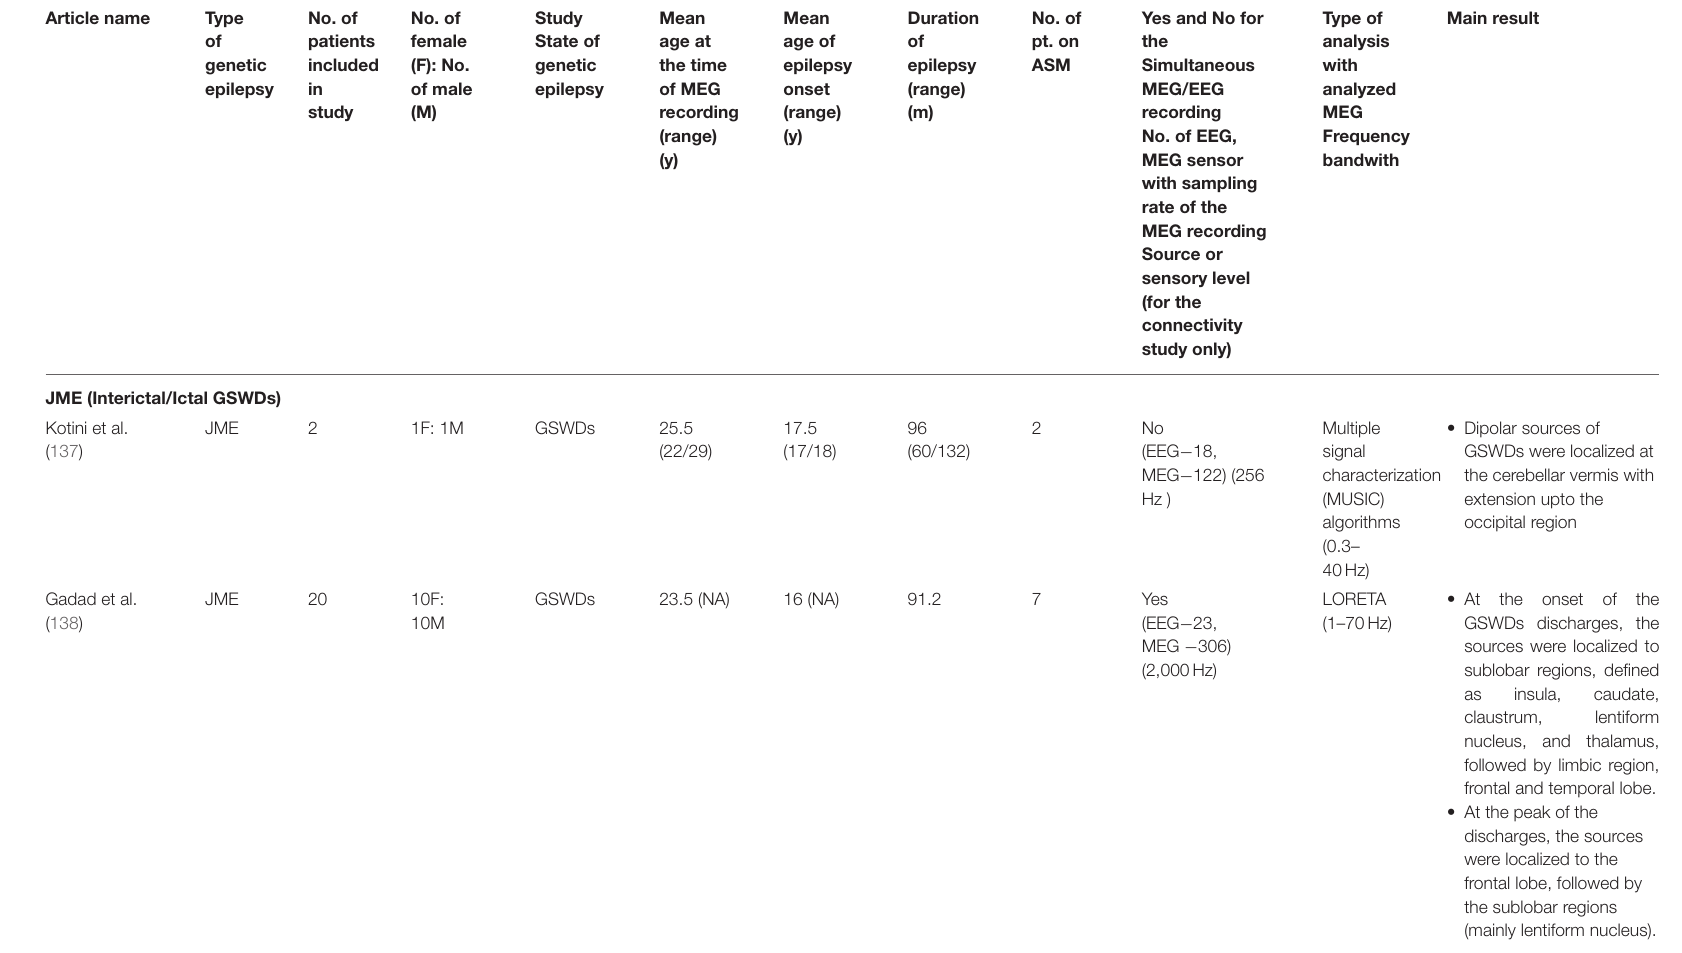
TABLE 3 | Showing all the published study characteristics and main outcomes on juvenile myoclonic epilepsy and combined genetic